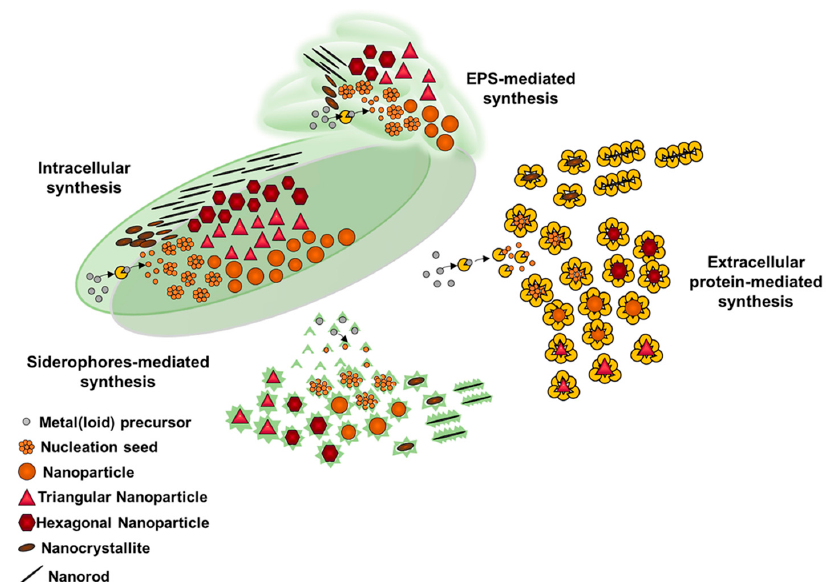
Figure 2. Schematic representation of the diverse biogenic nanomaterial morphologies obtained by actinobacterial biotransformation of metal salt precursors through intra- or extracellular (i.e., mediated by siderophores, extracellular proteins, and extracellular polymeric substances (EPS)) processes.